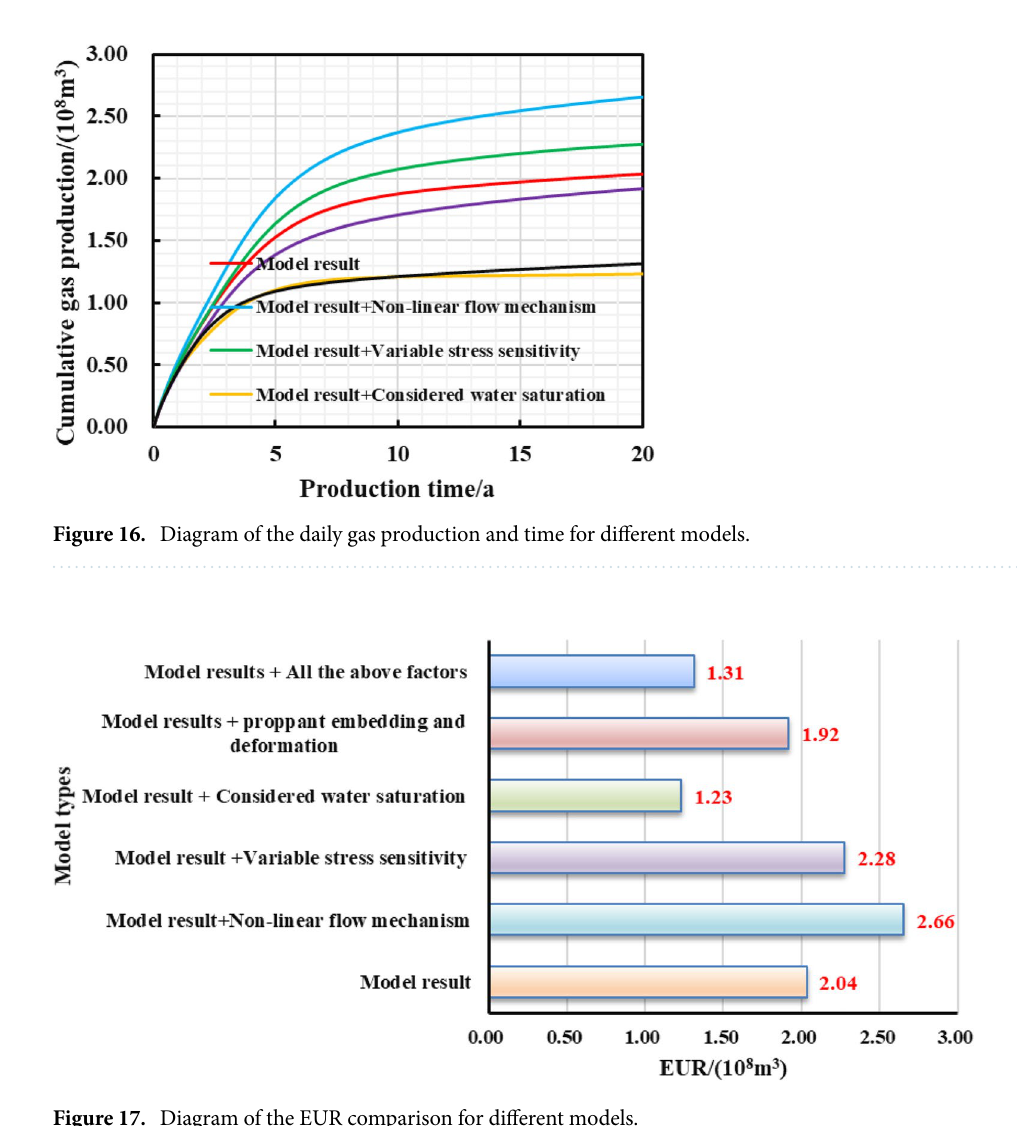
Figure 17. Diagram of the EUR comparison for different